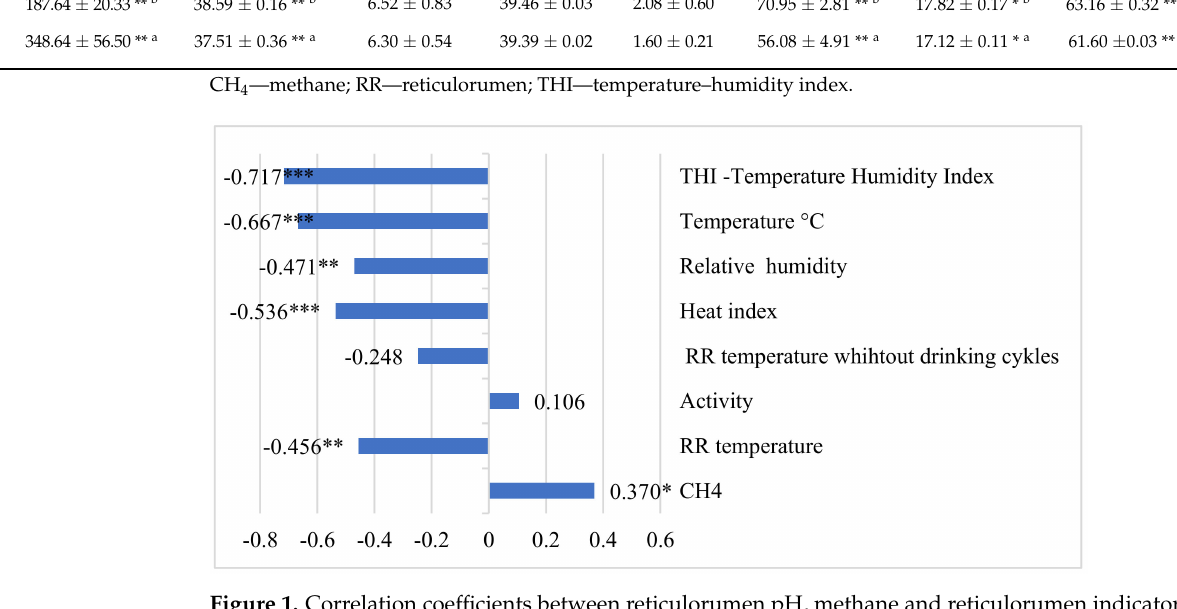
Figure 1. Correlation coefficients between reticulorumen pH, methane and reticulorumen indicators. * p < 0.05 , ** p < 0.01, *** p < 0.001. CH 4 —methane; RR—reticulorumen. Methane was weakly negatively corelated with heat index (r = − 0.341, p < 0.05), and weakly positively with RR pH (r = 0.370, p < 0.05) (Figure 2).